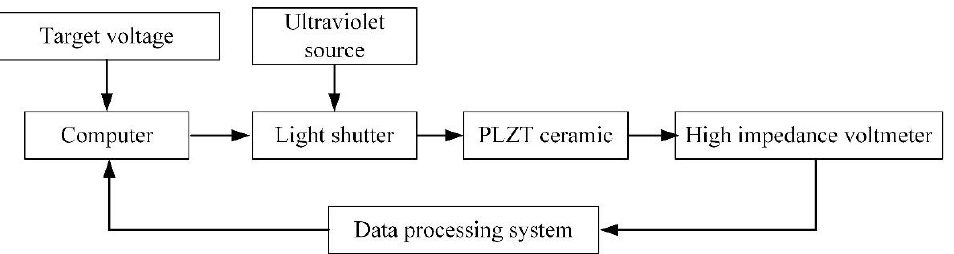
Figure 18. The static performance of the light-operated microgripper under irradiation with differ- ent intensities.